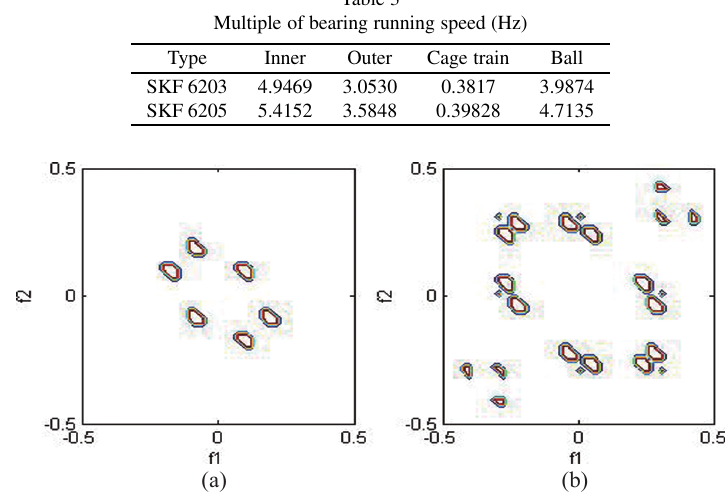
Fig. 5. Two fault feature images (a) inner fault binary feature image (b) ball fault binary feature image.